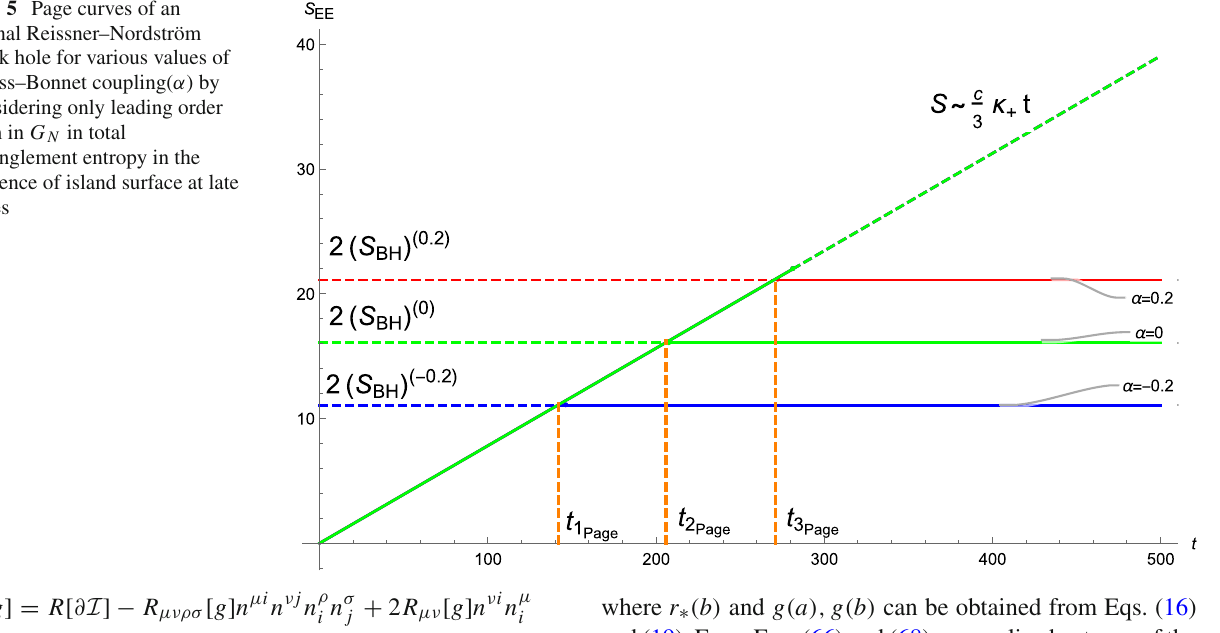
Fig. 5 Page curves of an eternal Reissner–Nordström black hole for various values of Gauss–Bonnet coupling( α ) by considering only leading order term in G N in total entanglement entropy in the presence of island surface at late